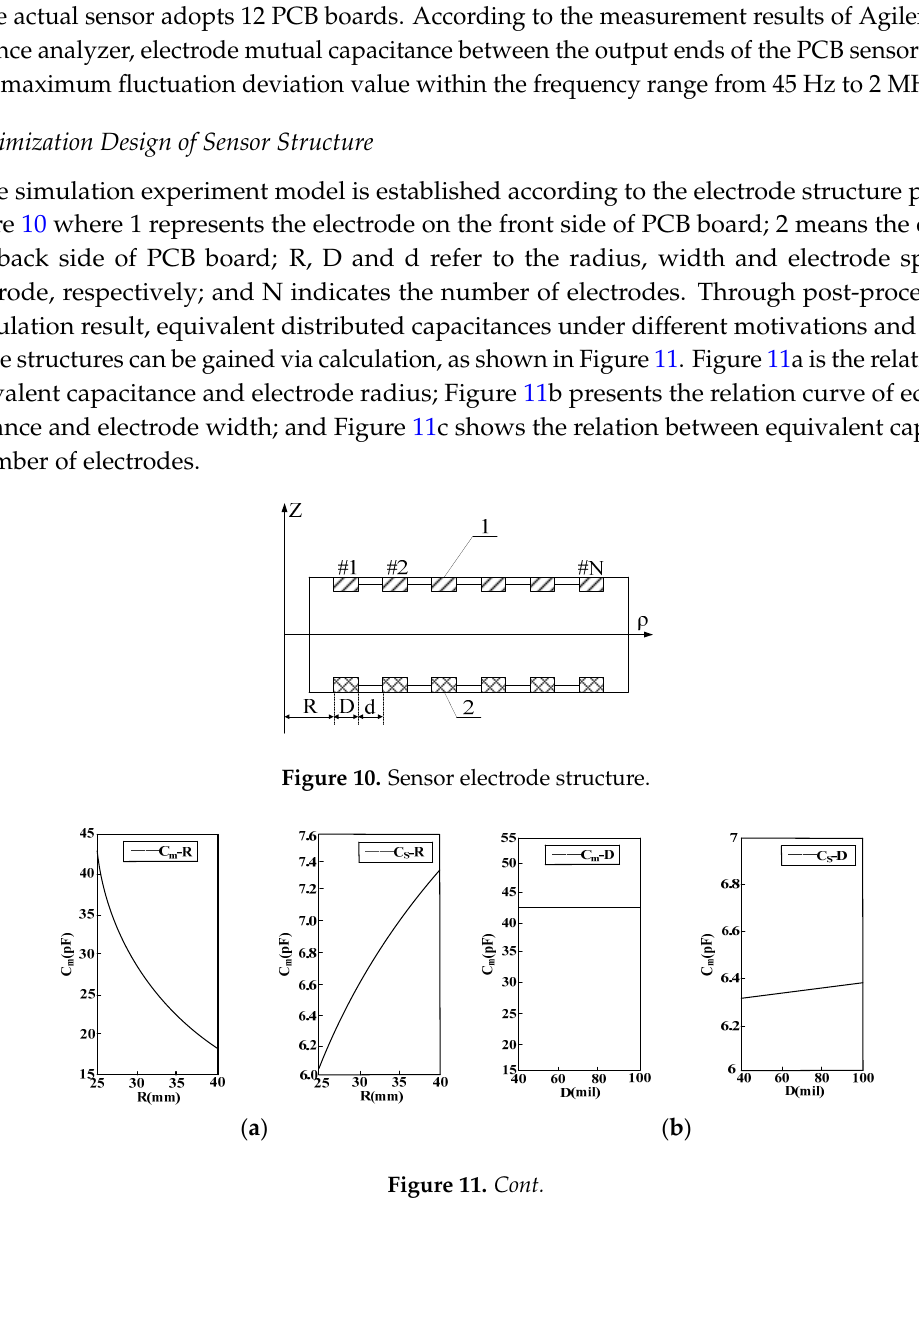
Table 1. Parameters of sensor.